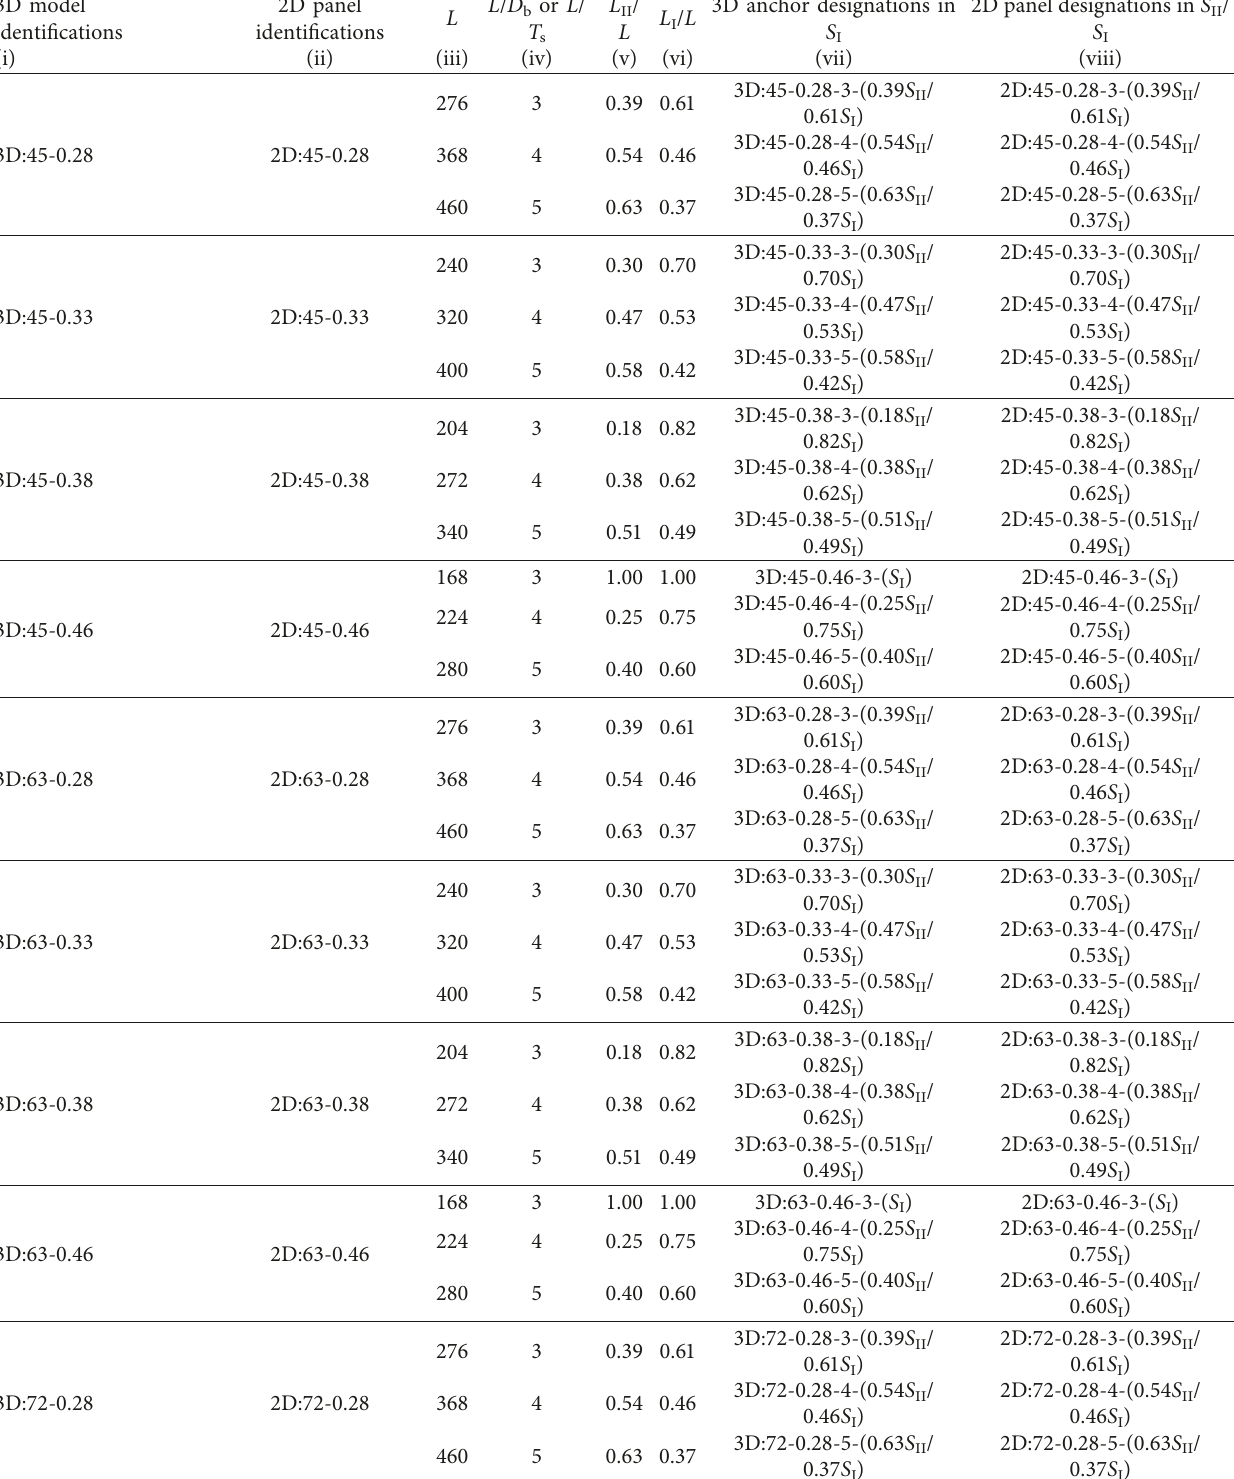
Table 3: Detail thickness of sand I ( S I ) and sand II ( S II ) in layered sand deposit ( S II / S I ) and 3D model and 2D panel and their designations in S II / S I